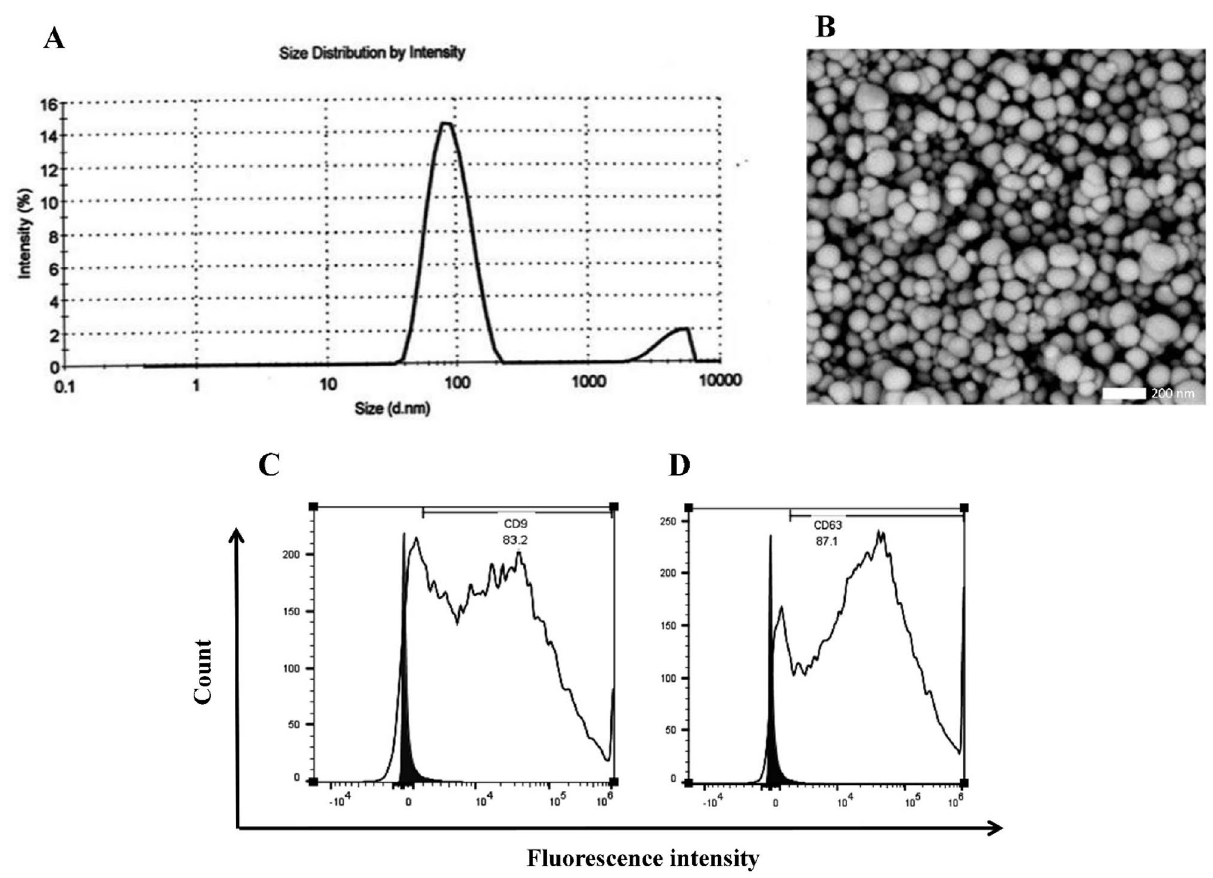
Figure 2. Characterization of hUCSC-EVs. The results of DLS showed that 91.2% of the solution ingredients had an average diameter of 90.89 nm ( A ). Electron microscopy confirmed EV’s size and shape ( B ). Flow cytometry analysis confirmed that hUCSC-EVs expressed CD9 ( C ) and CD63 ( D ). DLS dynamic light scattering, hUCSC-EV human umbilical cord mesenchymal stem cell-extracellular